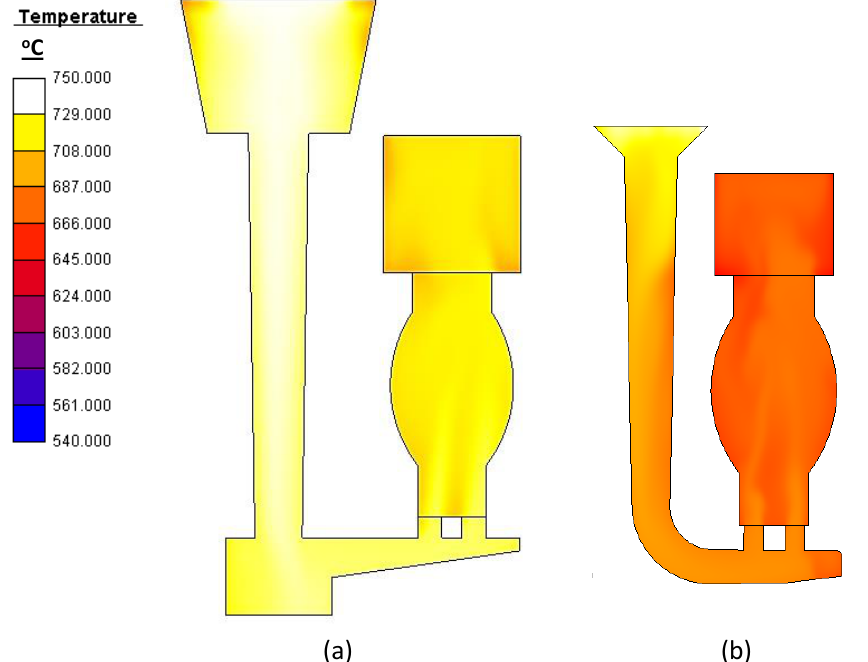
Figure 8. Casting temperature profile for both parts after ending the filling process: ( a ) sand casting. ( b ) 3DP casting.